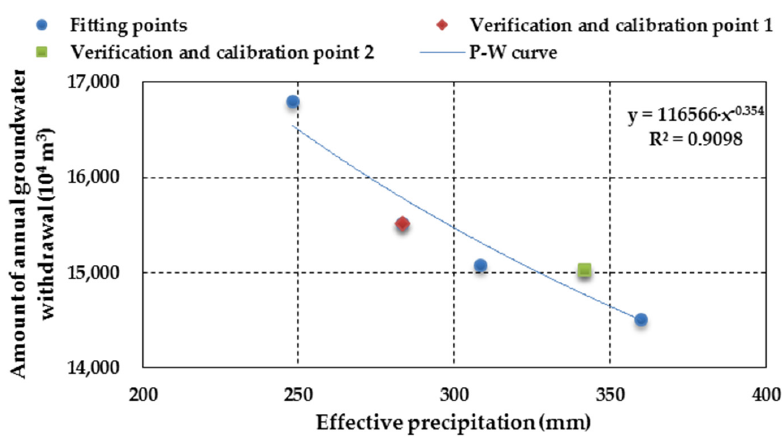
Figure 5. The effective precipitation and agricultural groundwater exploitation amount (P-W) curve of Quzhou County. Quzhou